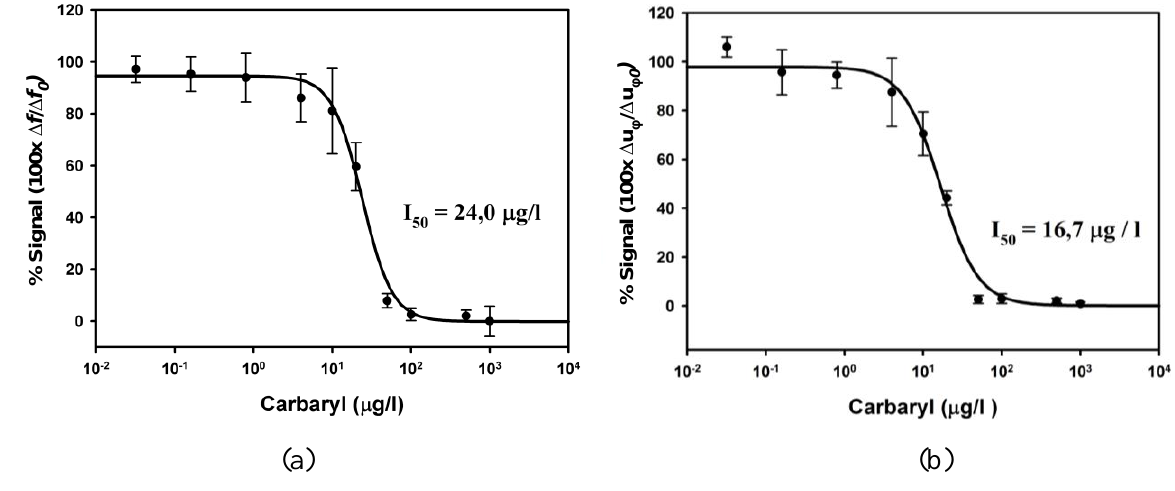
Figure 8. Average standard curve for the carbaryl piezoelectric immunosensor: (a) by using the classical frequency-shift characterization with the balanced-bridge oscillator proposed elsewhere [54,89], and (b) by using the phase-shift characterization method and interface.